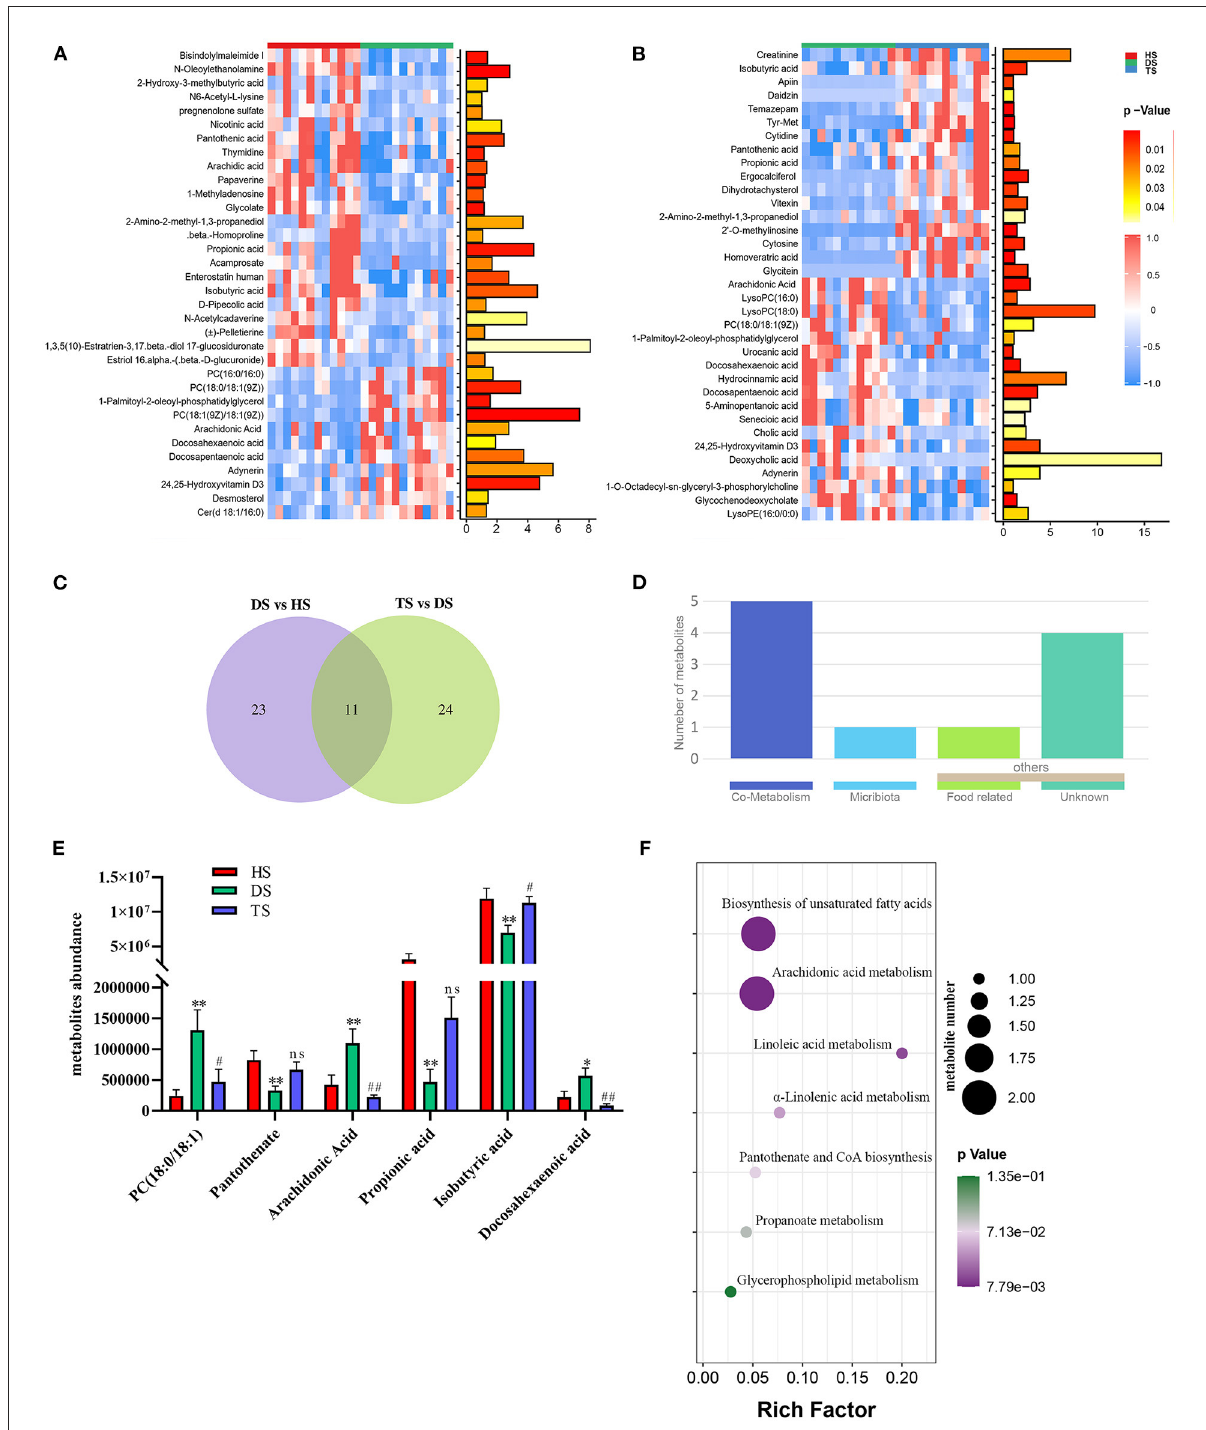
FIGURE4 The effect of Pueraria lobata polysaccharide (PLP) on diarrheal calf metabolites. (A) Heatmap of the 34 notably different metabolites between DS vs. HS; (B) Heatmap of the 35 notably altered metabolites between DS vs. TS; (C) Veen diagram showed that 11 of the same metabolites were identified in different groups; (D) The roles of same metabolites were further analyzed; (E) 6 key metabolites concentrations from intestinal contents in different groups; (F) The bubble diagrams of metabolic pathways. HS, healthy calf fecal sample; DS, diarrheal calf fecal sample; TS, PLP treatment diarrheal calf fecal sample. * P < 0.05, ** P < 0.01 DS vs. HS; # P < 0.05, ## P < 0.01 TS vs. DS; ns, no